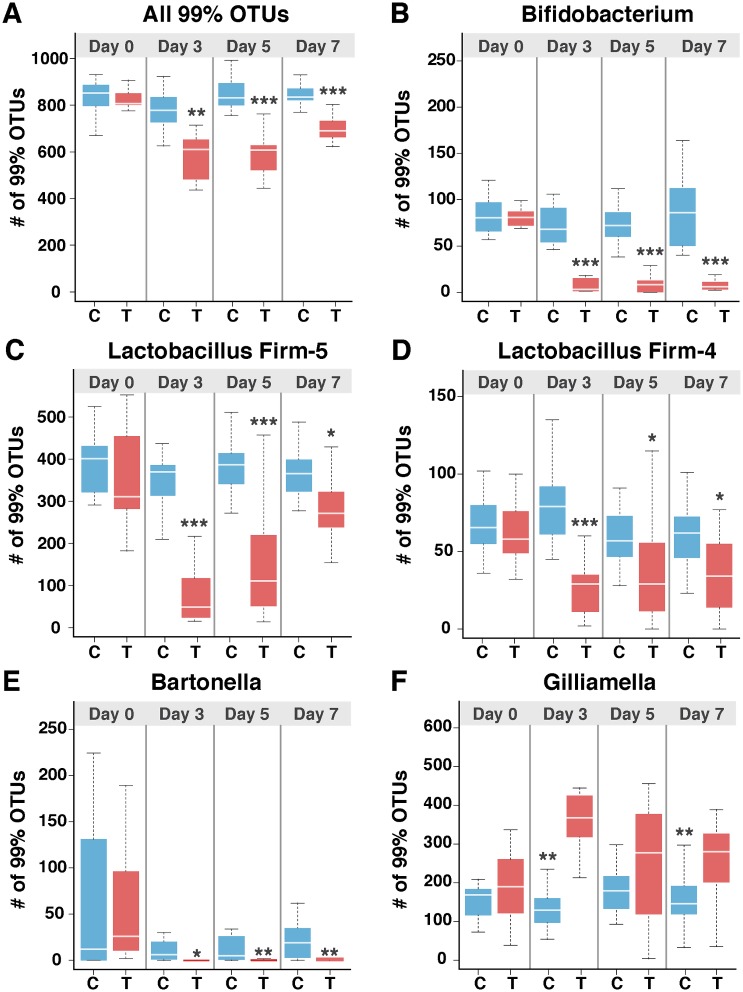
Changes in fine-scale bacterial diversity in tetracycline-treated bees based on 99% OTUs detected at Days 0, 3, 5, and 7 post-treatment.A) Total numbers of bacterial 99% OTUs present in control and treatment bees B-E) Numbers of 99% OTUs for the four species (Bifidobacterium, Firm-5, Firm-4, and B. apis) that displayed a significant decrease in diversity at Days 3, 5, and 7 post-treatment. F) Numbers of OTUs for the genus Gilliamella, which showed significant increases in OTU diversity at Days 3 and 7 in treatment bees. Box-and-whisker plots show high, low, and median values, with lower and upper edges of each box denoting first and third quartiles, respectively. * = p < 0.05, ** = p < 0.001 and *** = p < 0.0001, Wilcoxon rank sum tests. See S4 Data for 99% OTU data.